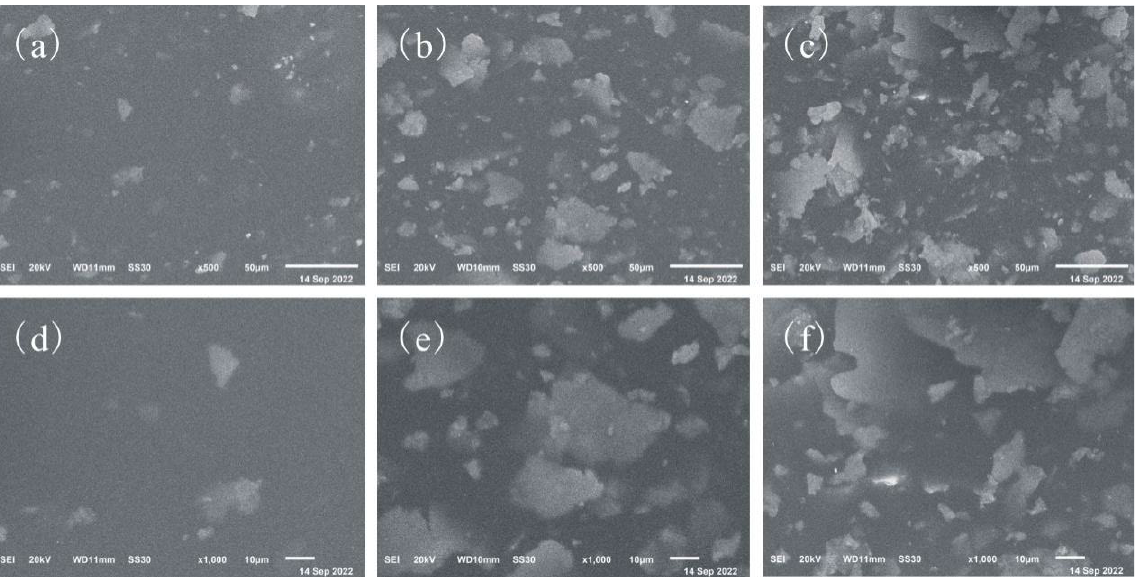
Figure 3. SEM images of coatings with contents of brass powder of 20 wt% ( a , d ), 40 wt% ( b , e ), and 50 wt% ( c , f ).